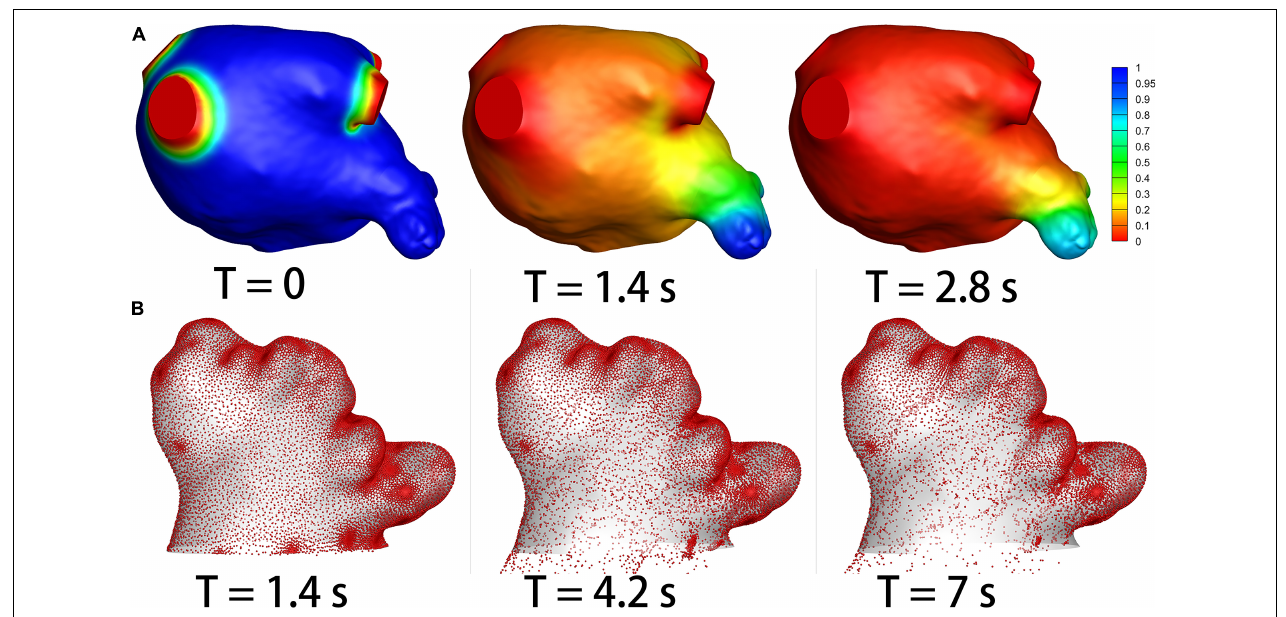
FIGURE 3 | The results of species-transport and DPM models. (A) The contour of the initial blood. The initial blood show in blue, and the fresh blood show in red. (B) The particle